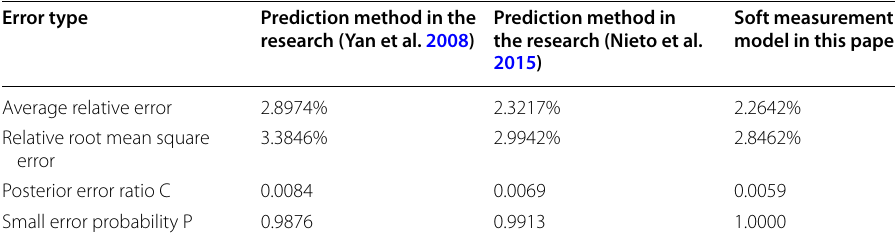
Table 4 Prediction errors of the three models based on the statistical test